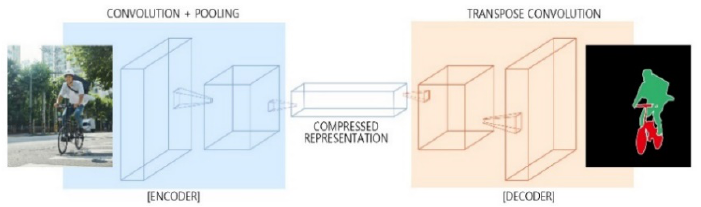
Figure 1. Structure of encoder-decoder.